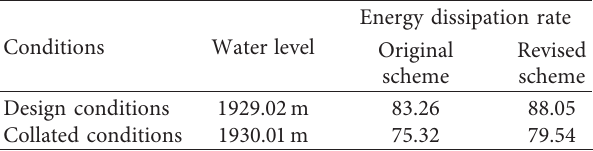
Table 3: Energy dissipation rate of the